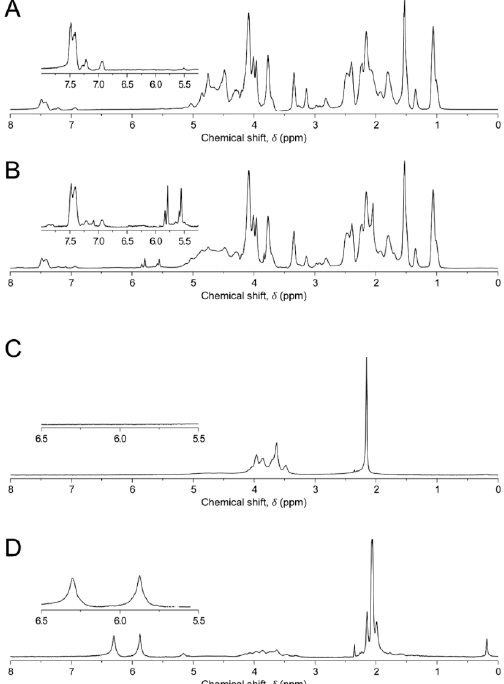
Figure 3. Proton Nuclear Magnetic Resonance ( 1 H NMR) spectra of hydrogels. ( A ): gelatin; ( B ): gelatin methacrylamide (GelMA); ( C ): hyaluronic acid (HA); ( D ): hyaluronic acid methacrylate (HAMA). Areas of interest are inset within each frame. Aromatic peaks in gelatin/GelMA are present at ~chemical shift ( δ ) 7.4 ppm, with the two free protons on the methacrylate groups present at δ 5.6 and δ 5.8 ppm respectively. In HA, the peak from the N -acetyl protons is present at ~ δ 2.1 ppm, with the methacrylate protons used for degree of functionalization (DOF) measurements present in HAMA at δ 5.8 and δ 6.3 ppm.